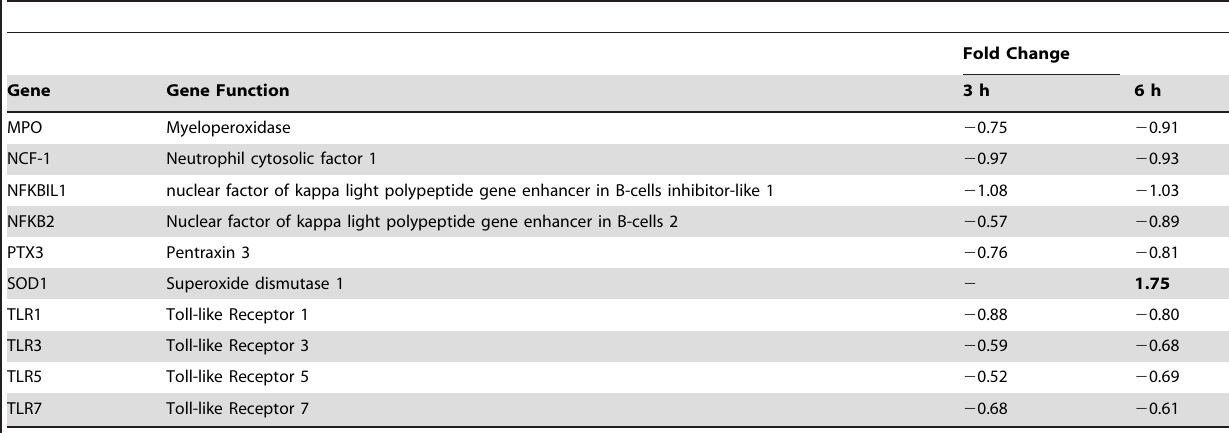
Table 2. Gene Expression in A549 epithelial cell layer induced by addition of A. fumigatus germ tubes.